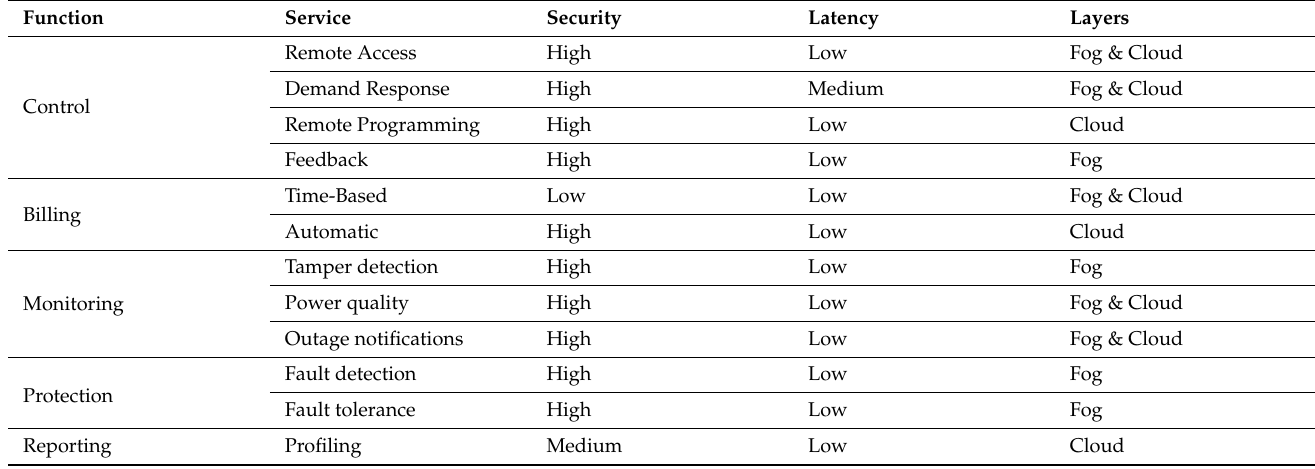
Table 1. AMI services with the corresponding